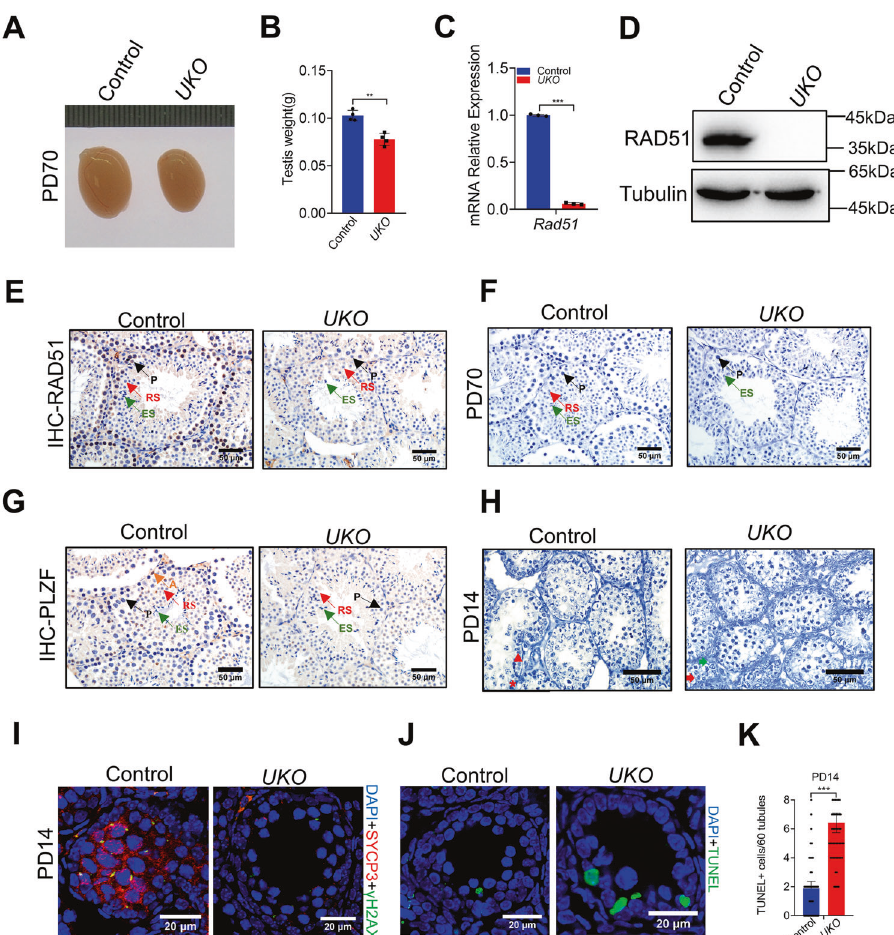
( D ) were conducted to determine the knockout ef fi ciency of RAD51 - UKO mice compared to control mice in testes. Tubulin was used as the loading control. Data are presented as means ± S.D. ** p < 0.01. E Immunohistochemical staining of RAD51 in seminiferous tubules was used to con fi rm the knockout ef fi ciency at PD70. (P: pachytene spermatocyte; RS: round spermatid; ES: elongating spermatid). Scale bar is 50 μ m. F Haematoxylin staining was conducted in seminiferous tubules to analyze the number and type of testicular cells in RAD51 - UKO and control testes at PD70. (P: pachytene spermatocyte; RS: round spermatid; ES: elongating spermatid). Scale bar is 50 μ m. G Immunohistochemical staining of PLZF was applied to analyze in the seminiferous tubules of RAD51 - UKO mice at PD70. (A: spermatogonia; P: pachytene spermatocyte; RS: round spermatid; ES: elongating spermatid). Scale bar is 50 μ m. H Haematoxylin staining was carried out in the seminiferous tubules of RAD51 - UKO and control mouse testes at PD14. (red triangle: spermatogonia; red star: pachytene spermatocytes; red arrow: type B spermatogonia; green arrow: mitotic cells). Scale bar, 50 μ m. I Immuno fl uorescence staining of SYCP3 and γ H2AX was applied to the seminiferous tubules of RAD51 - UKO and control testes at PD14. Scale bar, 20 μ m. J ATUNEL assay was applied to control and RAD51 - UKO testes. Cells strained green are TUNEL-positive cells and DNA was stained with DAPI. Scale bar, 20 µm. K Statistics of a number of TUNEL-positive cells per tubule in control and RAD51 - UKO testes at PD14 tubules were counted. Student ’ s t -test, error bars indicate SEM. *** P <